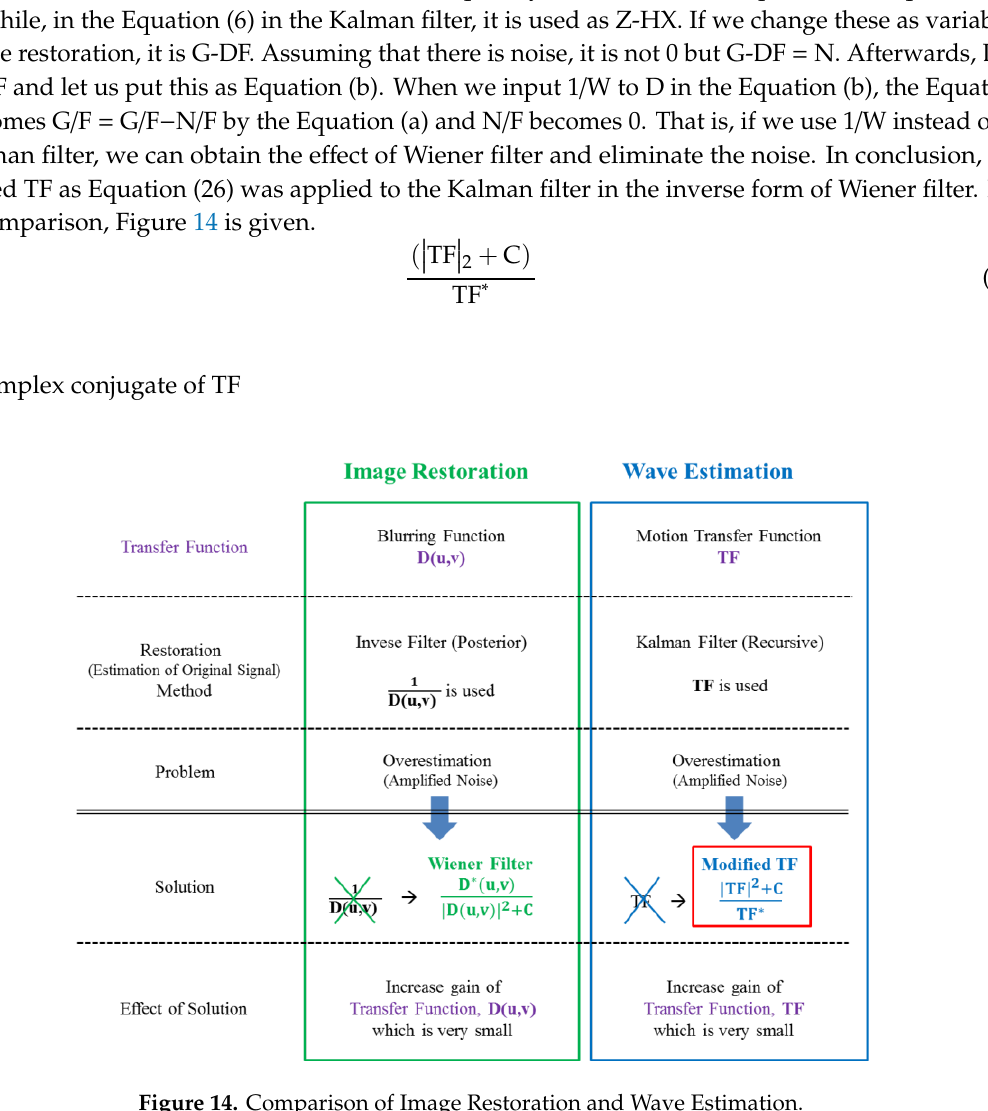
Figure 15. Modified Heave response amplitude operator (RAO) (red dotted line) of FPSO.